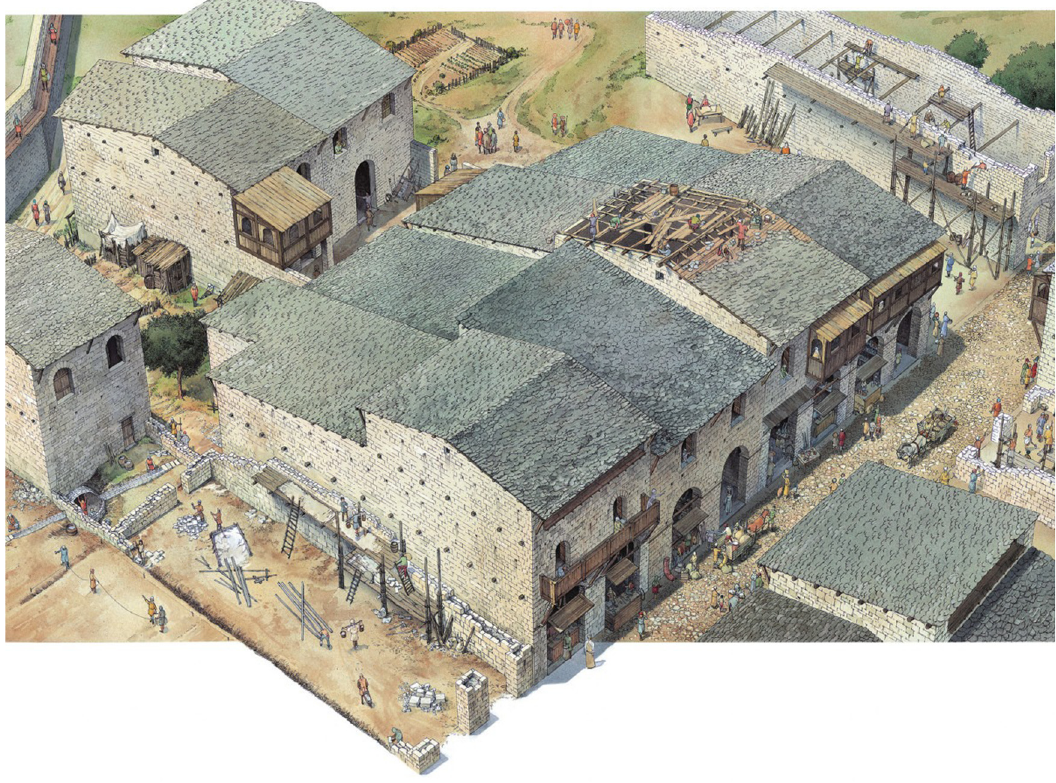
Figure 3: Graphic reconstruction of a neighborhood of Podium Bonizi ( Ink Link Studio – Cultural Heritage Communication & University of Siena )